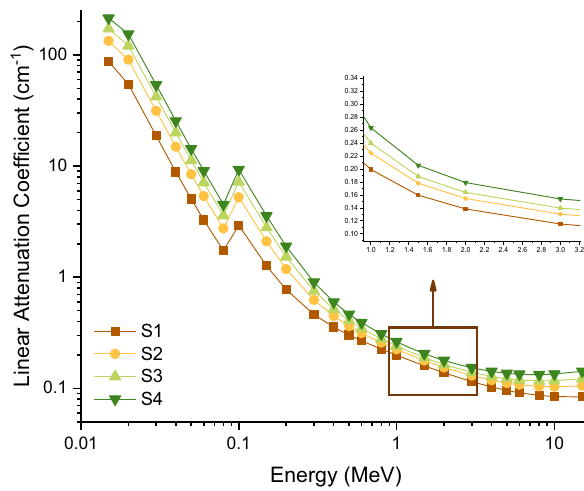
Figure 6: Variation of linear attenuation coe ffi cient ( cm − 1 ) with photon energy ( MeV ) for all S1 – S4 glasses.